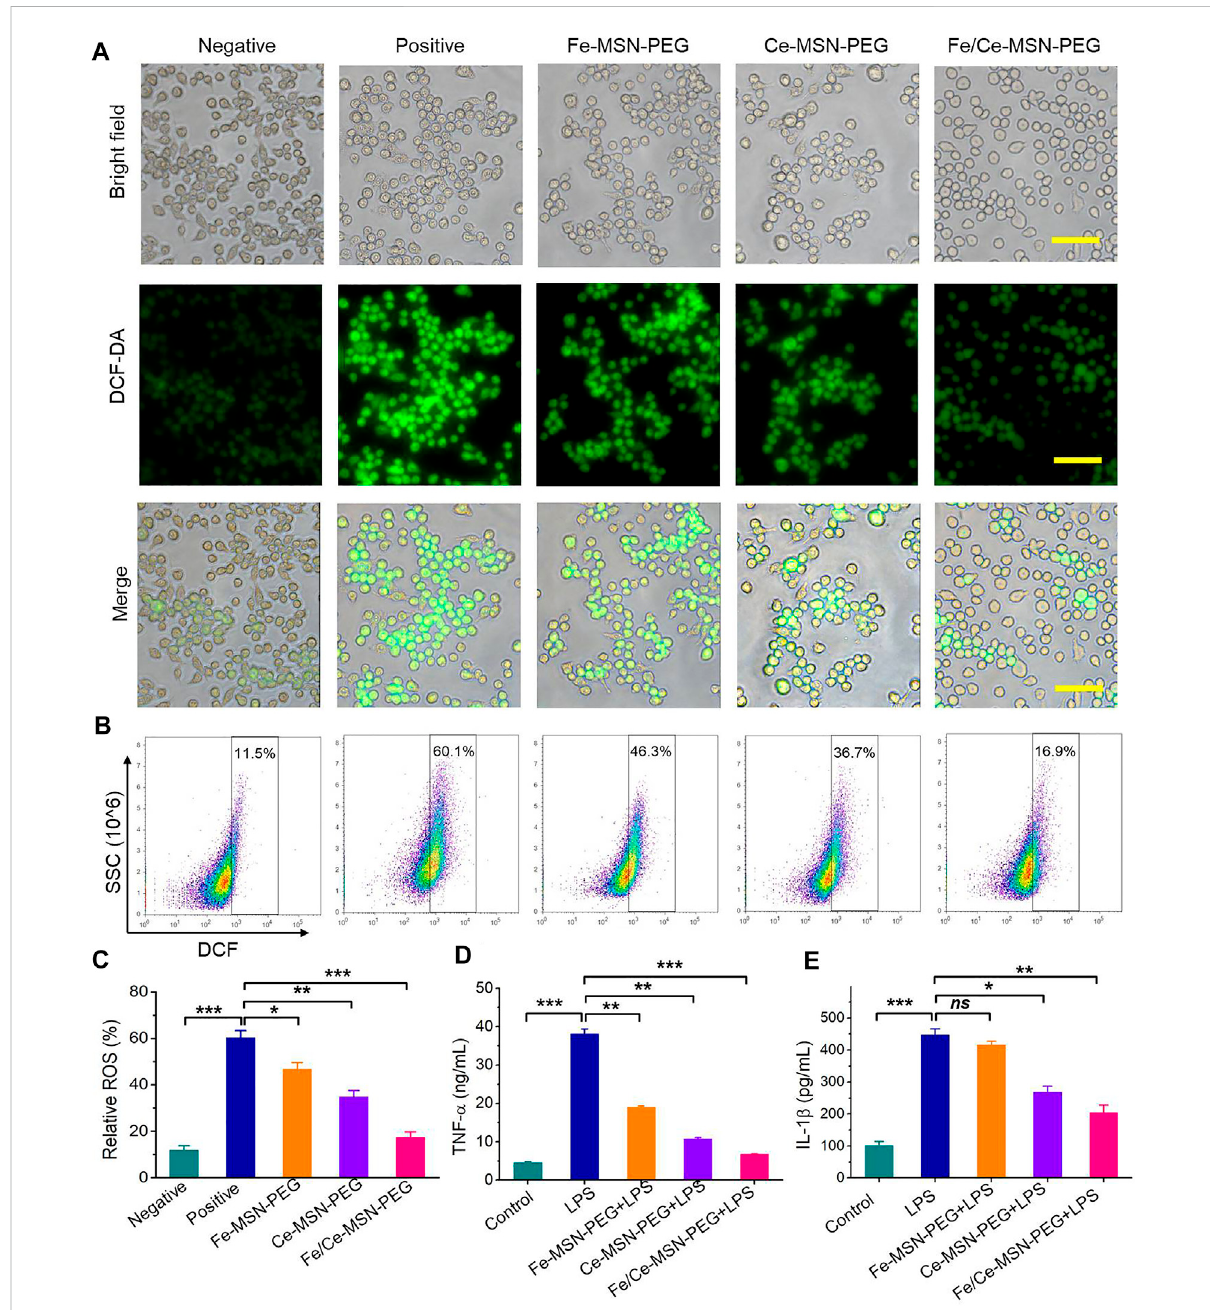
FIGURE 6 ROS-scavenging and anti-in fl ammatory activity of Fe/Ce-MSN-PEG NPs in vitro . (A – C) Representative ROS staining and quantitative data of RAW264.7 cells under different treatment conditions incubated with 200 µM H 2 O 2 . Scale bar: 50 μ m. The levels of (D) TNF- α , (E) IL-1 β . Data are presented as mean ± SE ( n = 3). * p < 0.05, ** p < 0.01, *** p < 0.001; ns, no signi fi